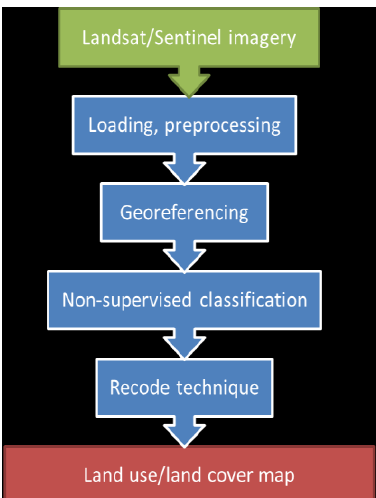
Fig.4: Flowchart of methodology for land-use/land-cover and change